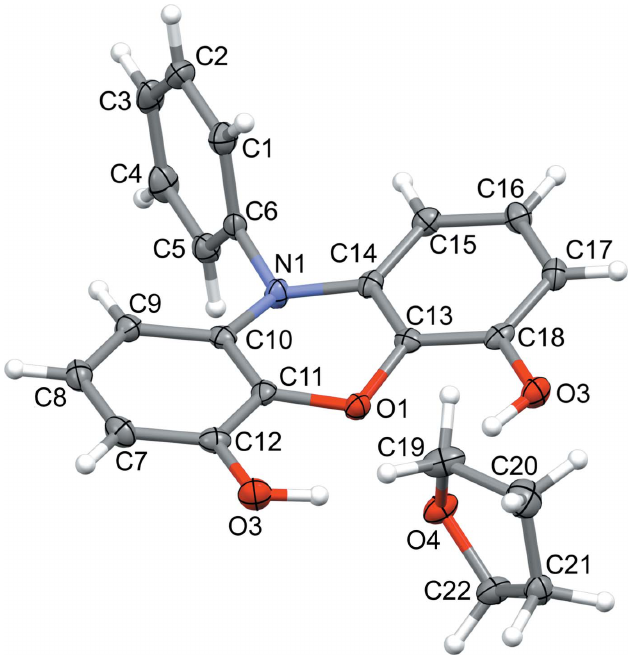
Figure 2 Ellipsoid plot (50%) of the title solvate. The minor component of disorder for the THF solvent molecule is omitted for the sake of clarity.